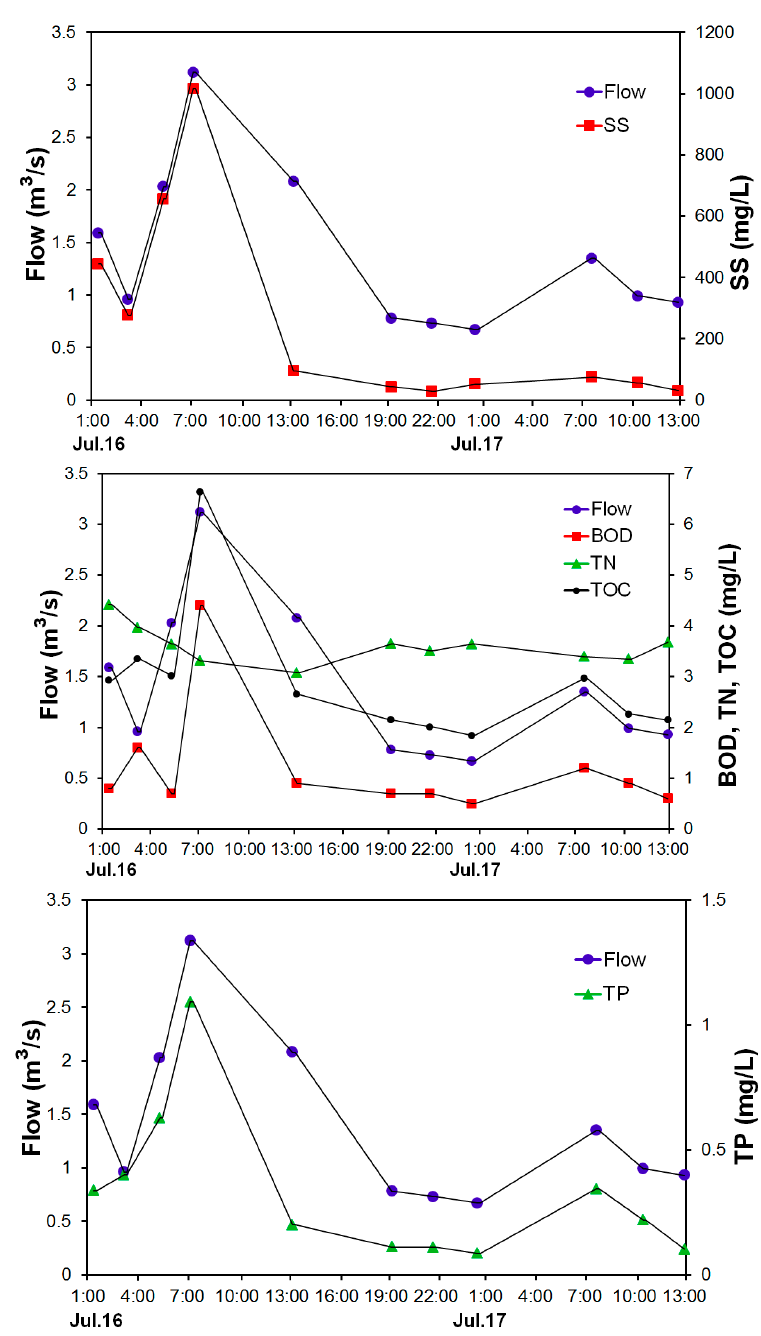
Figure 4. Variation of stormwater runoff water quality and flow at Naedongcheon (16 and 17 July 2016).